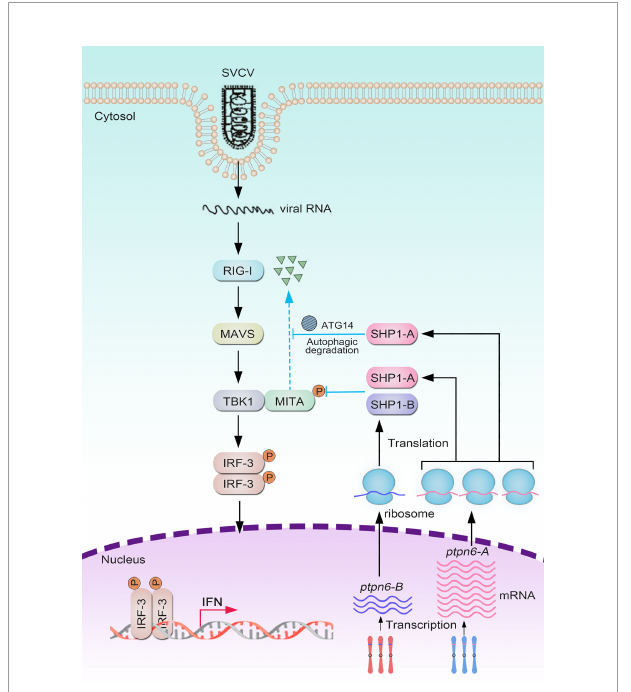
FIGURE 9 | Divergent mechanisms of Cgptpn6-A and Cgptpn6-B in negatively regulating RLR-mediated signaling